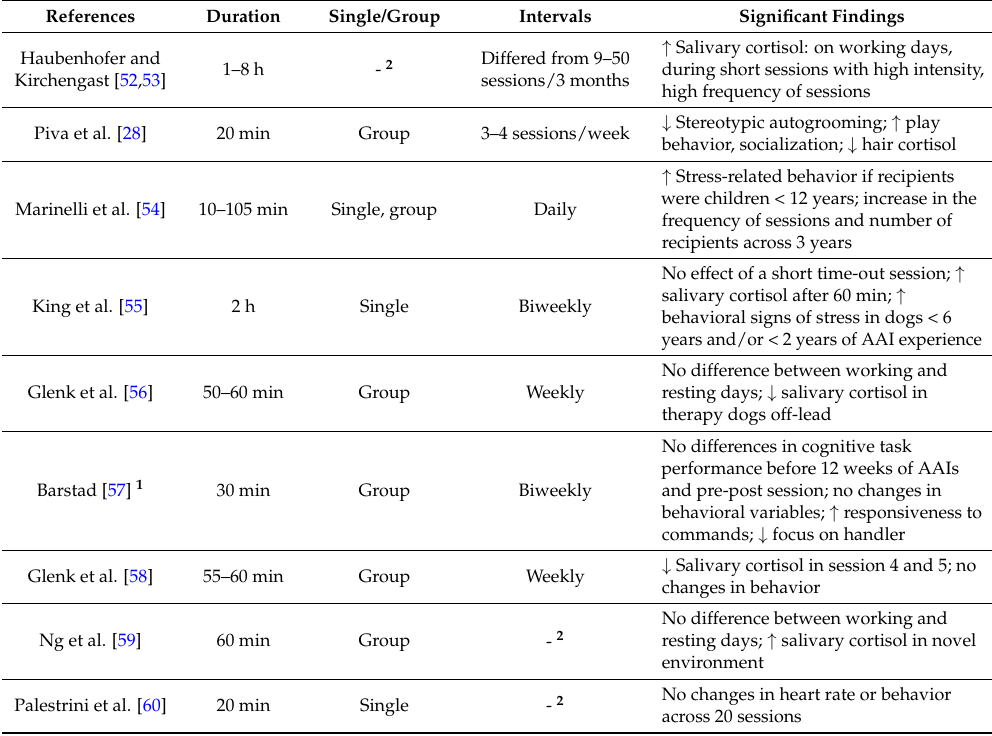
Table 2. AAI session characteristics including duration, organization of recipients (single or group sessions), between session intervals and significant